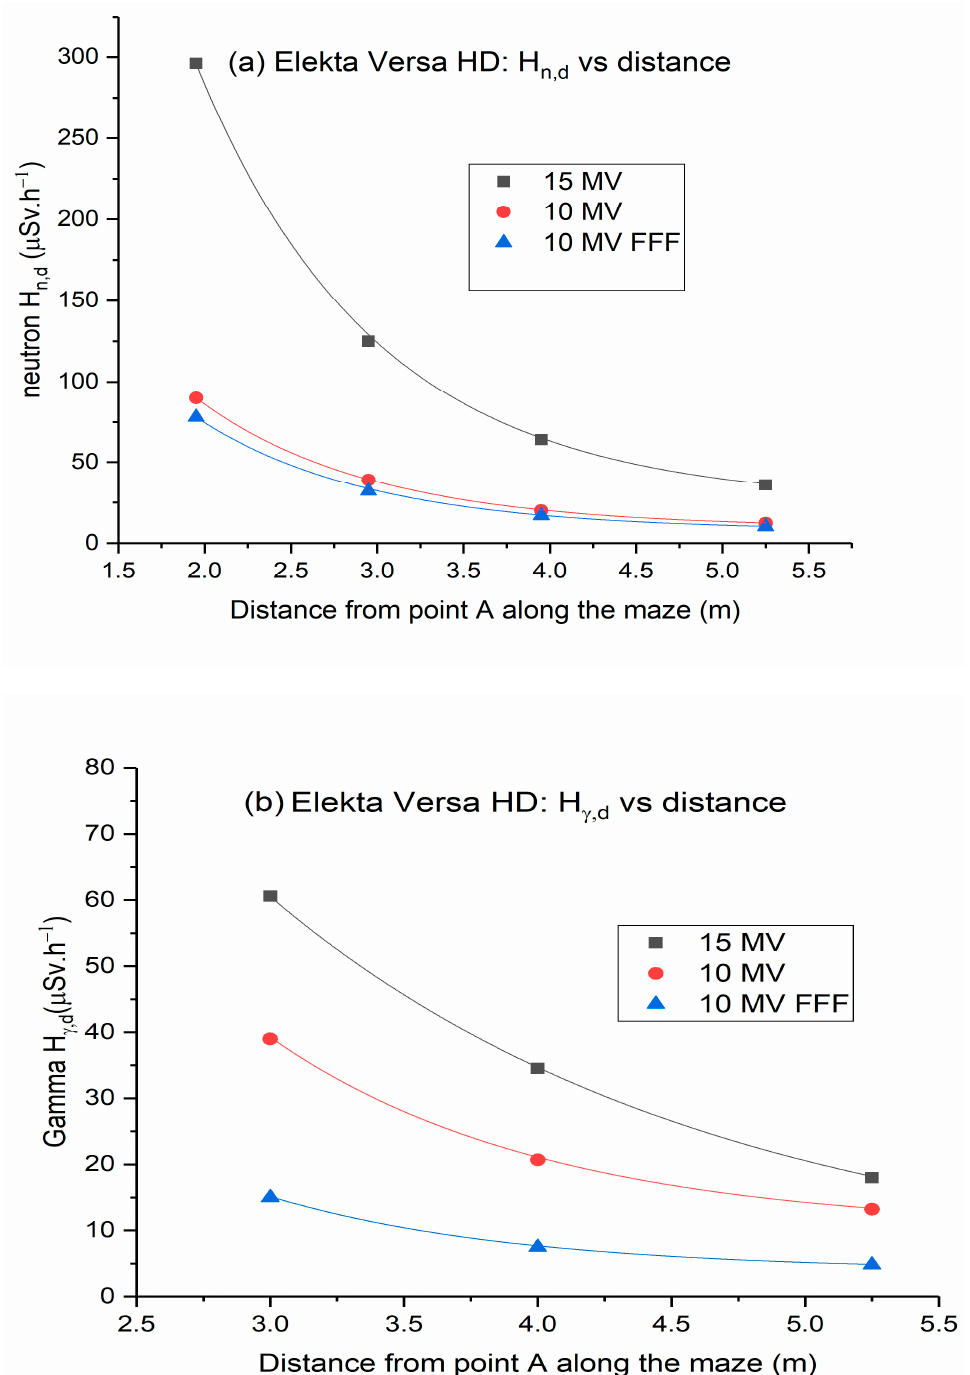
Figure 3. Dose equivalent rates along the maze of Elekta Versa HD linear accelerator: ( a ) neutron dose rates; ( b ) gamma dose rates (Error bars are not shown because they are too small to be visible in the